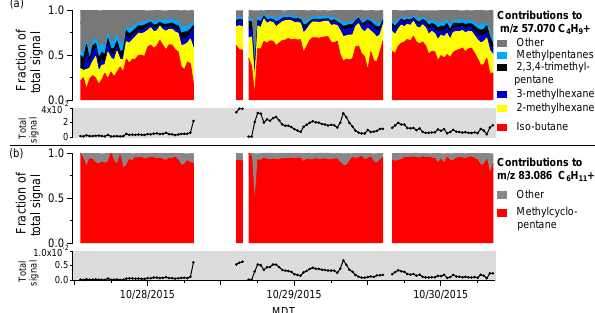
Figure 9. Contributions to two masses based on GC-CIMS mea- surements of ambient air. “Total signal” is normalized counts per chromatogram. (a) m/z 57 C 4 H +